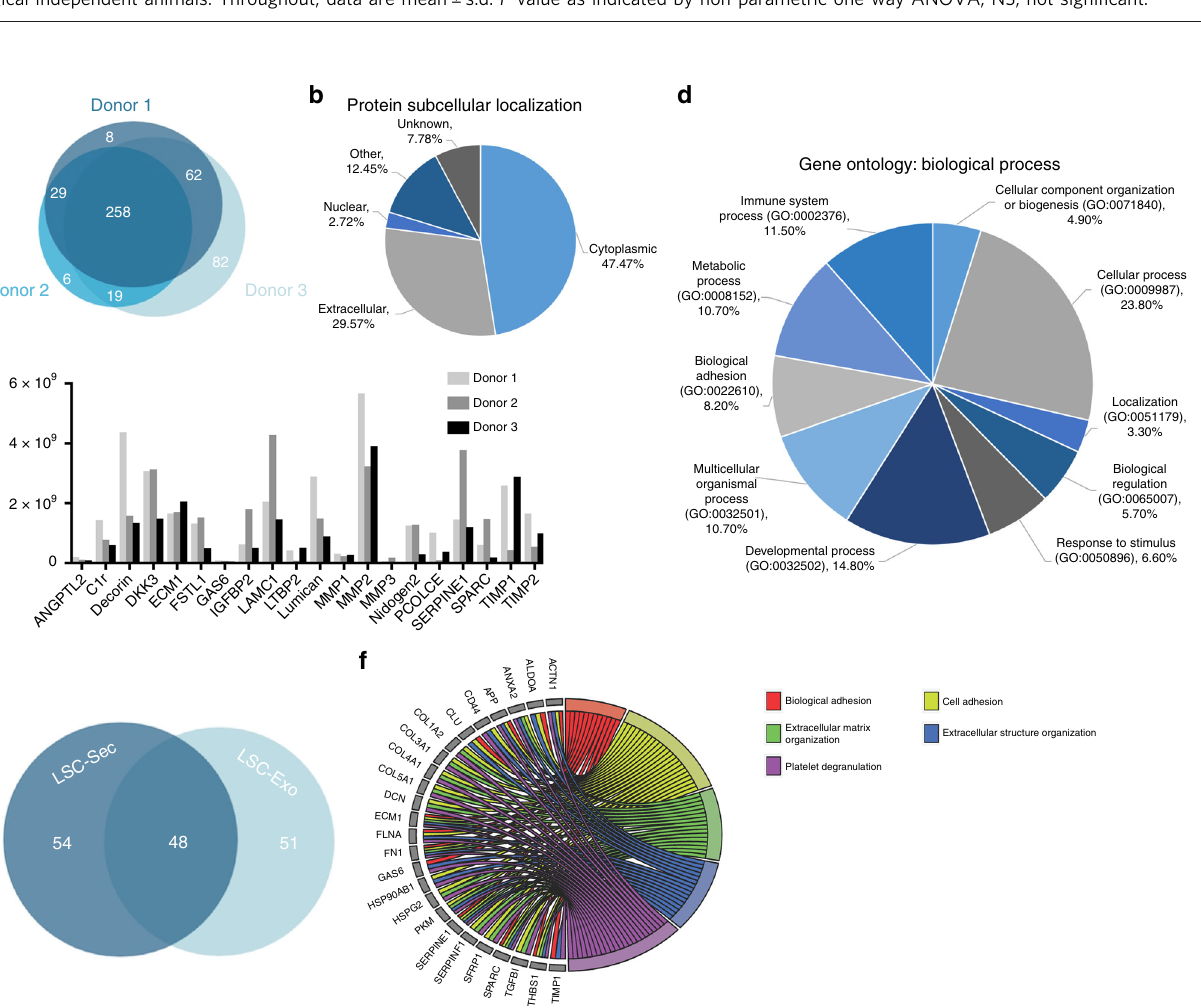
Fig. 3 Lung repair and fi brosis in mice after silica-injury. a The experimental study schematic of the silica-induced fi brosis study in A/J mice; n = 10 biological independent animals per group. b Representative TUNEL staining of apoptotic cells for each treatment group and quanti fi cation of percent of Tunel positive cells; Scale bar = 50 μ m; each dot represents data from one animal; n = 5 biological independent animals. c Representative H&E staining. Scale bar = 100 μ m. d Quanti fi cation of fi brosis by Ashcroft score; each dot represents data from one animal; n = 8 biological independent animals. Ashcroft score was performed by averaging the score from two blinded and one non-blinded scorer. e Gomori ’ s trichrome staining: muscle fi bers (red), collagen (blue), nuclei (black-purple) and erythrocytes (red). Scale bar = 100 μ m. f Representative picrosirius red staining; Collagen types I and III (red). Scale bar = 100 μ m. g Quanti fi cation of pulmonary hydroxyproline levels; each dot represents data from one animal; n = 4 biological independent animals. h Representative immunostaining of lung sections for aquaporin 5 (AQP5), pro-surfactant protein C (Pro-SPC) and von Willebrand Factor (vWF) Scale bar = 50 μ m. i – k Quanti fi cation of percent pixel intensity of AQP5 + ( i ), ProSPC + ( j ), and vWF + ( k ). Each dot represents data from one animal; n = 4 biological independent animals. Throughout, data are mean ± s.d. P -value as indicated by non-parametric one-way ANOVA; NS, not signi fi cant.